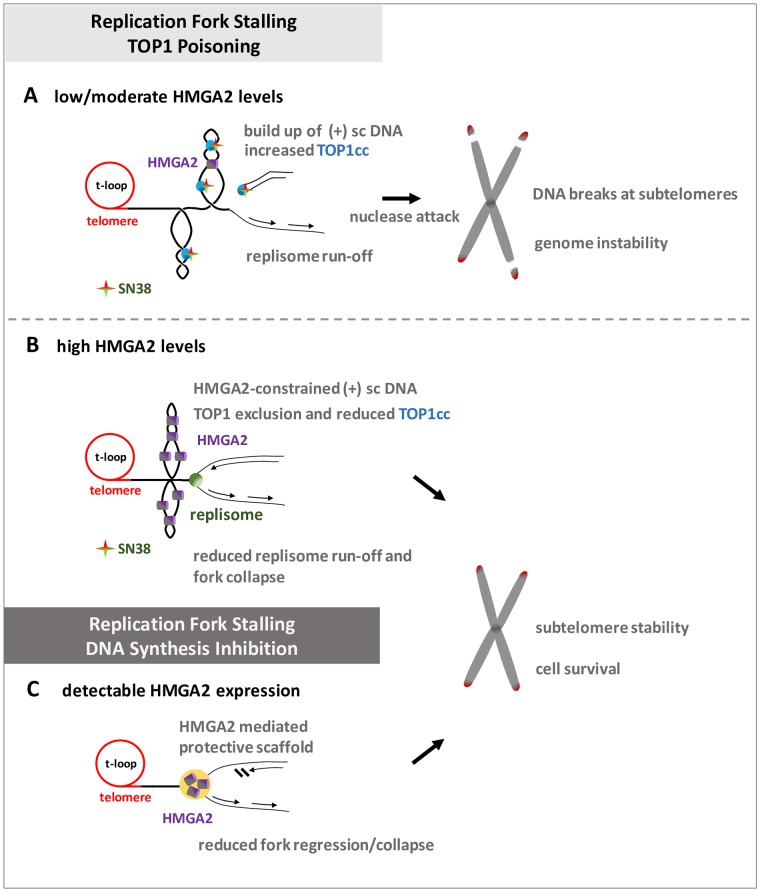
Models for the regulation of subtelomere stability by HMGA2 as a result of replication stress induced by SN38 or HU.Replication fork stalling at human subtelomeres as a result of TOP1 poisoning or DNA synthesis inhibition. (A) HMGA2 levels determine SN38 treatment responses, with low/moderate HMGA2 levels bound to (+) sc DNA potentiating the accumulation of TOP1-DNA cleavage complexes (TOP1cc), hence leading to more frequent replication run-off events and fork collapse that will ultimately separate subtelomeres from the rest of chromosomal DNA. (B) The accumulation of TOP1cc as a result of SN38 treatment is minimized at high HMGA2 levels due to a combination of constraining of (+) sc DNA and TOP1 exclusion from binding to its scDNA substrate, thereby preventing DSBs at the subtelomeres. (C) Such a varied response was not observed with DNA synthesis inhibition by HU since detectable HMGA2 expression always reduced fork collapse and promoted subtelomere stability and cell survival. Described in detail in the Discussion.